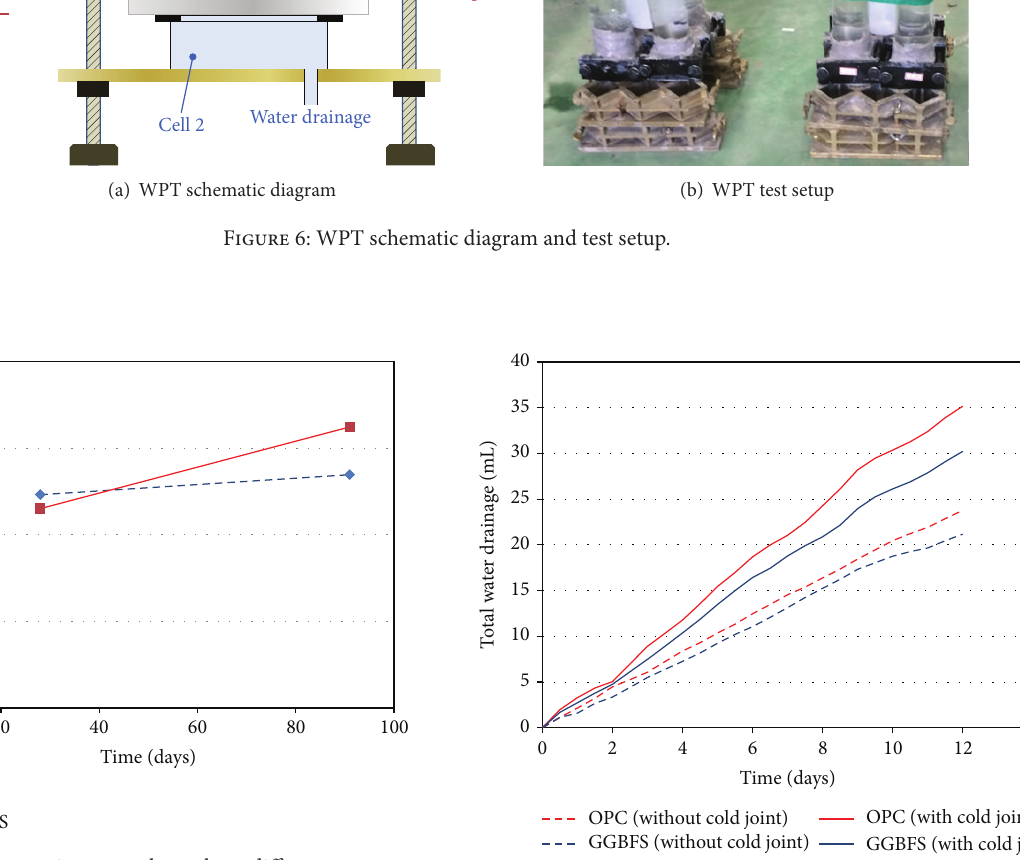
Figure 8: Cumulative water drainage over two